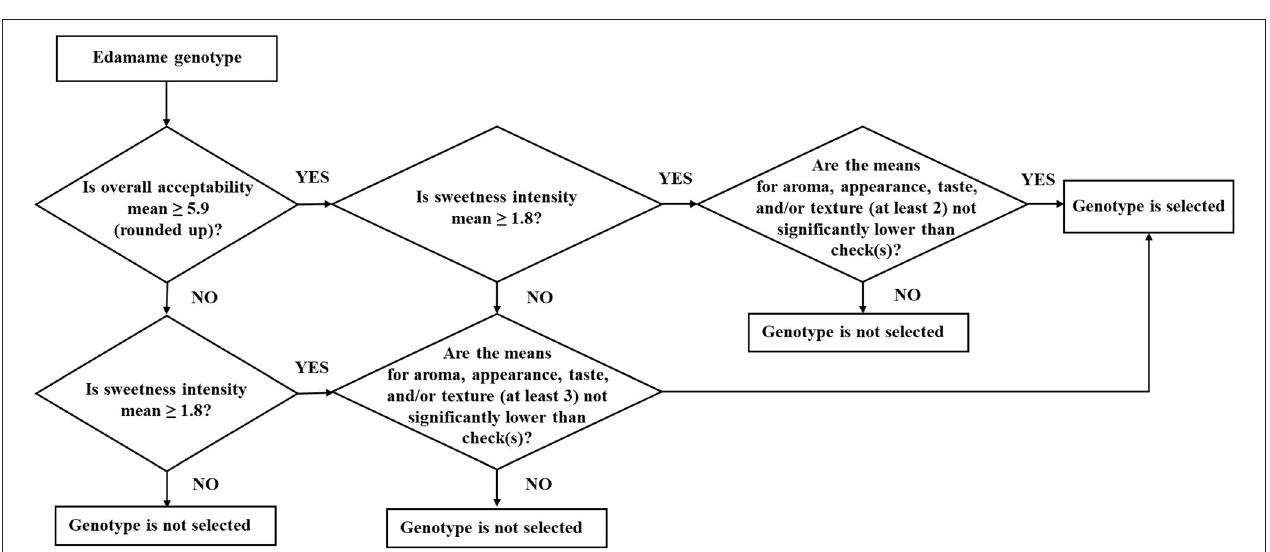
FIGURE 1 | Decision tree for selection of edamame genotypes based on sensory evaluation